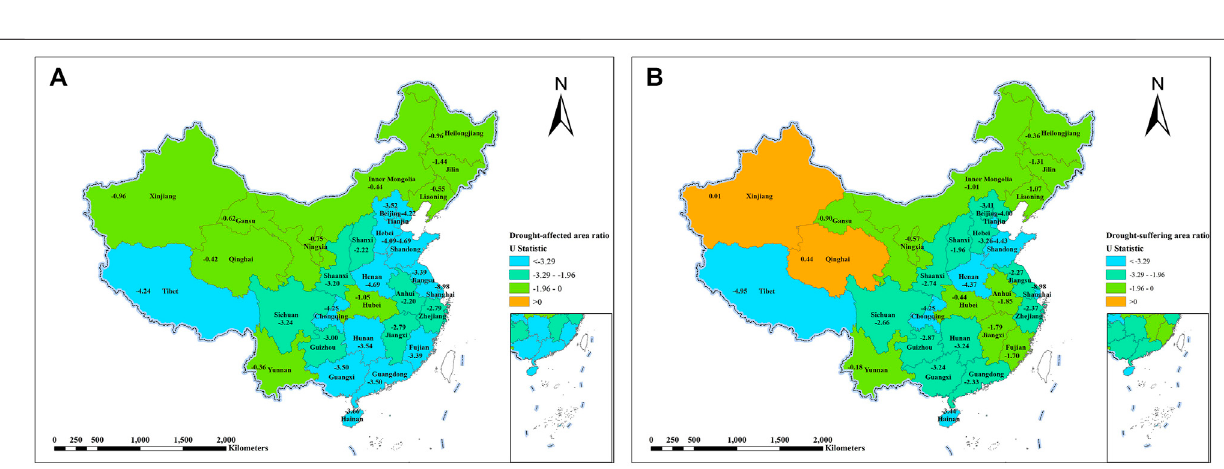
Frontiers in Environmental Science |